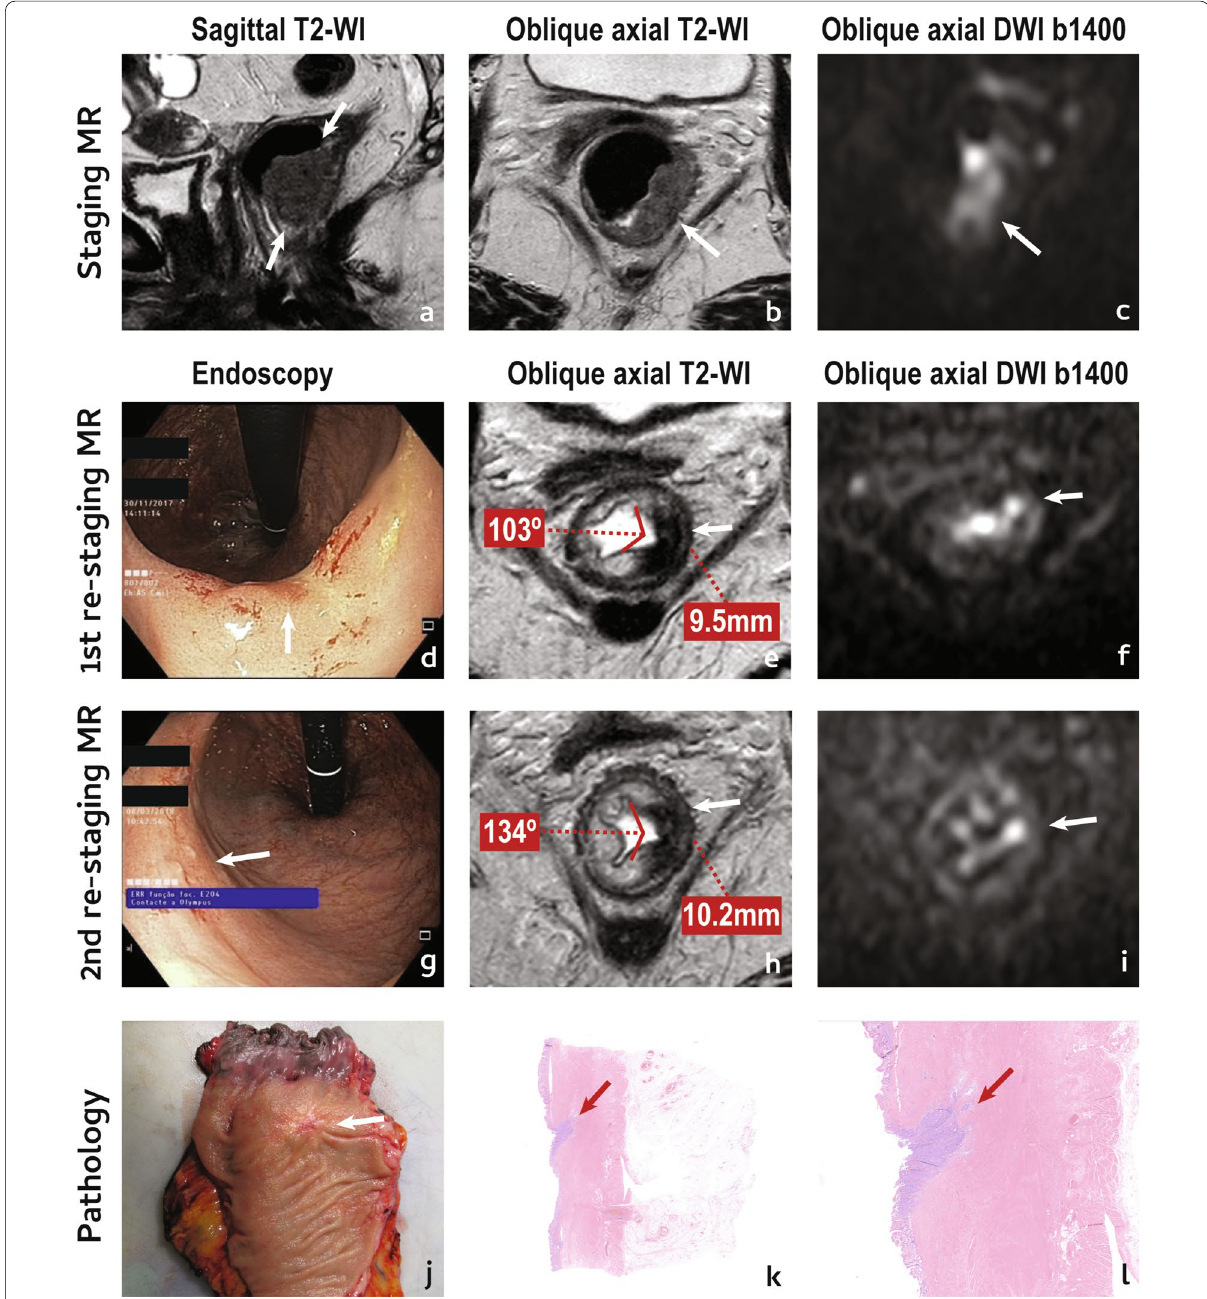
Fig. 8 “Near-complete” tumour response. An 83 year-old female presented with a low mrT2 (arrows in a , b ) mrN1a (not shown) EMVI cancer. She underwent NAT and was re-staged on endoscopy as grade 1 due to the presence of a red scar (arrow in d ), and on MR imaging as mrTRG2/3 given tumour bed was now a black scar with a single focus of intermediate signal intensity below endoluminal aspect, a bit displaced from the centre (arrow in e ), that presented with high signal intensity at high b value DWI (arrow in f ). Patient was considered a “near-complete” responder and was followed. At 2nd re-staging, an adenomatous mucosal abnormality was observed at the periphery of the scar (arrow in g ) and patient was considered a grade 2 on endoscopy. On MR imaging, she was now an mrTRG3 due to the expansion of the intermediate signal focus (arrow in h ), which was also more conspicuous on high b value DWI (arrow in i ). Patient underwent abdomino-perineal excision and specimen was a ypT3 ypN0 ypEMVI-TRG3 R0. The endoluminal regrowth was apparent on the gross examination of the fresh specimen (arrow in j ) and at histology was depicted as a focal persistent niche of tumour at the endoluminal aspect of the tumour bed (arrows in k and l ) growing in depth. It reached the mesorectal fat which was focally invaded (not